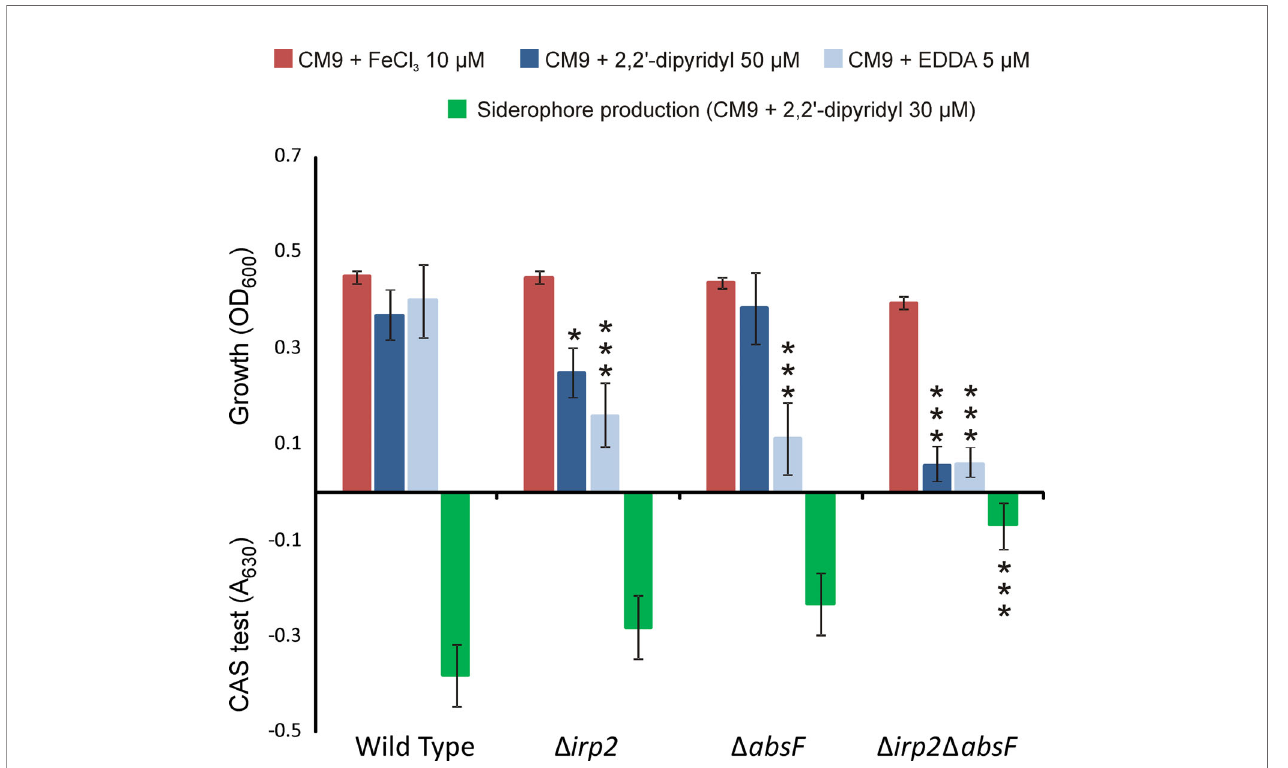
FIGURE 3 | Growth levels under low and high-iron availability and siderophore production (CAS assay) of V. neptunius PP-145.98 wild type and its derivative mutants D absF , D irp2 and D irp2- D absF . Asterisks denote statistically signi fi cant differences with the wild type strain (* P < 0.05 and *** P <